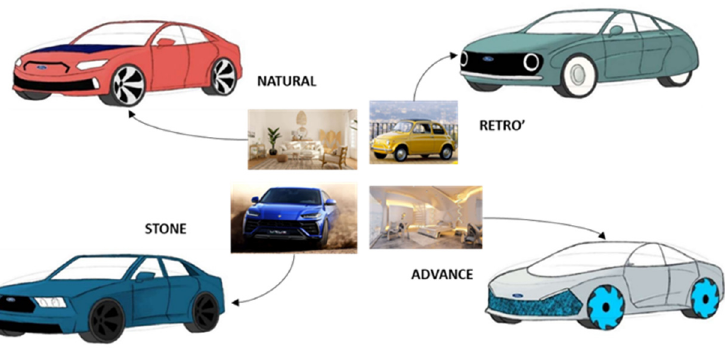
Figure 4. Sketches of the proposed car for the four different styles (Natural, Retro, Stone, and Advanced).